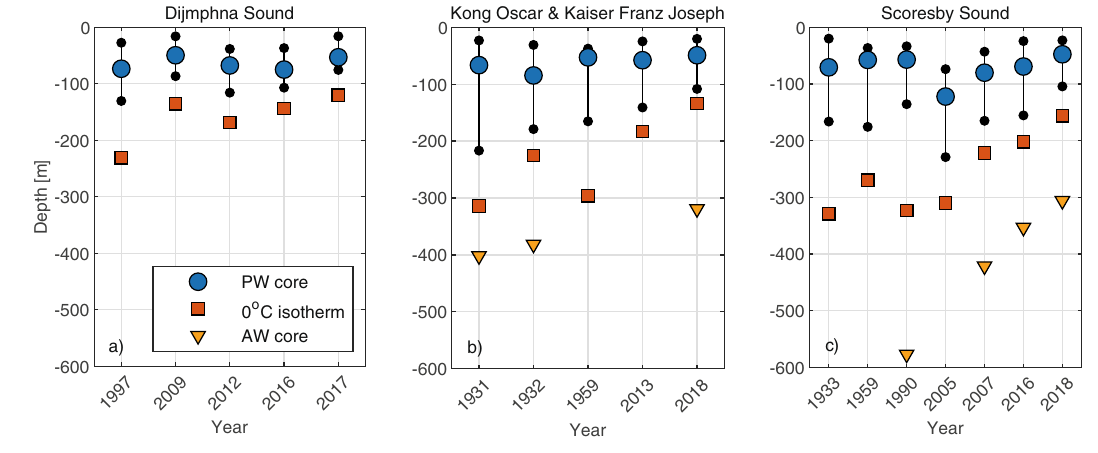
Fig. 3 | Vertical distribution of water masses in three deep sill fjord systems during July/August/September. Dijmphna Sound ( a ); Kong Oscar and Kaiser Franz Joseph fjords ( b ); and Scoresby Sound ( c ). The mean vertical placement of the Polar Water (PW) core (blue circles), the depth range occupied by PW (vertical